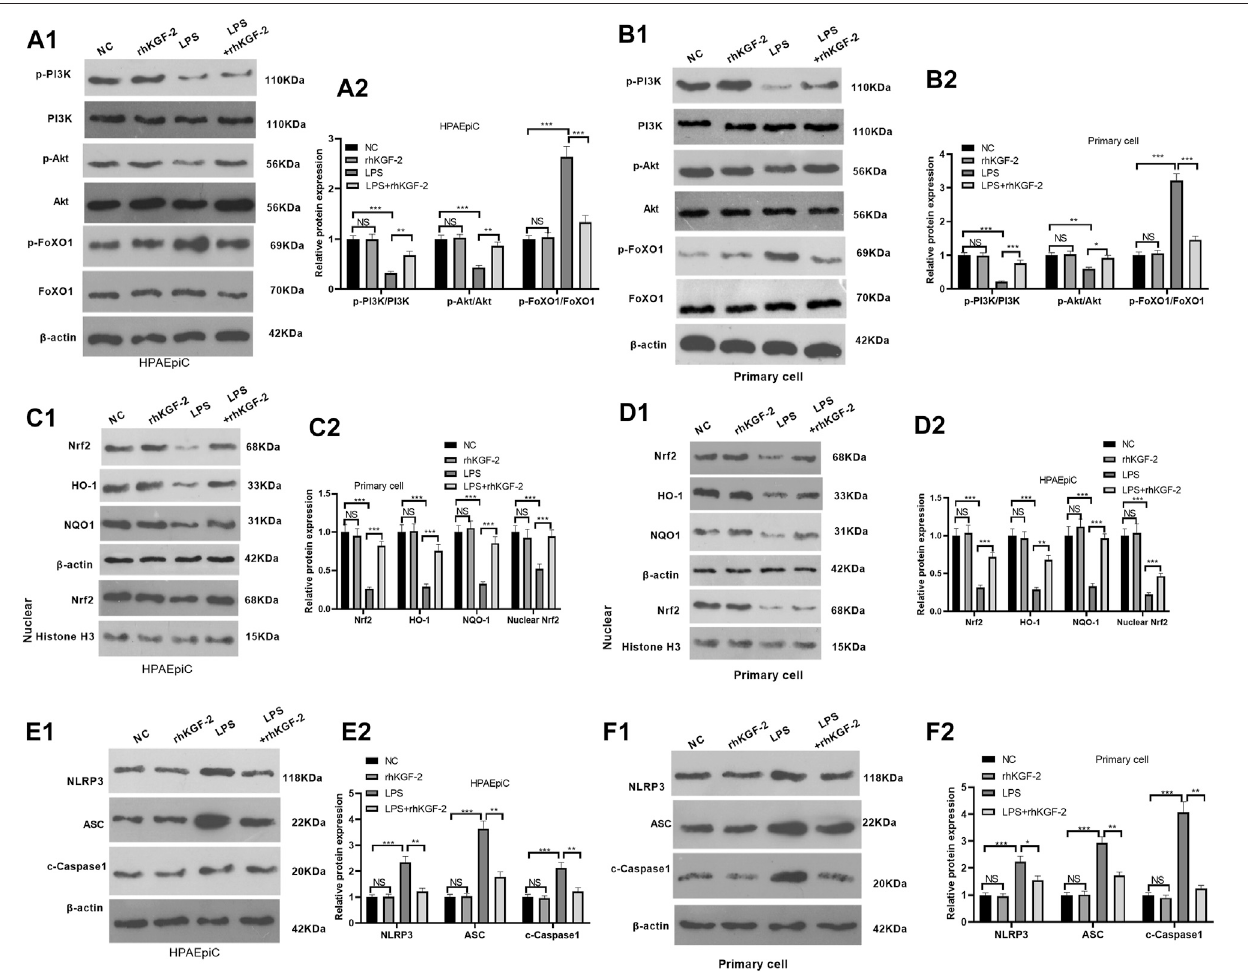
FIGURE 2 | The effect of rhKGF-2 on the expression of PI3K/Akt, Nrf2/HO-1/NQO1, and FoxO1-NLRP3-ASC-Caspase1 in fl ammasome. The HPAEpiC cells and primaryratalveolarepithelialcellsweretreatedwithLPS(10 μ g/ml)and/orrhKGF-2(10 ng/ml)for24 h. A1-A2 :WBwascarriedouttodeterminetheexpressionofPI3K/ Akt and FoxO1 in HPAEpiC cells. B1-B2 : WB was carried out to determine the expression of PI3K/Akt and FoxO1 in primary rat alveolar epithelial cells. C1-C2 . The protein levels of Nrf2, HO-1 and NQO1 in the HPAEpiC cells were detected by WB. D1-D2 . The protein levels of Nrf2, HO-1 and NQO1 in the primary rat alveolar epithelial cells were detected by WB. E1-E2 . WB was conducted to detect NLRP3-ASC-Caspase1 in HPAEpiC cells. F1-F2 . WB was conducted to detect NLRP3- ASC-Caspase1 in primary rat alveolar epithelial cells. The p-PI3K, p-AKT and p-FoxO1 were calculated using PI3K, AKT and FoxO1 as internal control, respectively. β -actin wasthe internal control of Nrf2, HO-1, NQO1 and NLRP3-ASC-Caspase1. Nuclear Nrf2 was calculated using HistoneH3 as internal control. The relative protein expression ( Y -axis) was calculated as fold change of NC group. The X -axis showed the grouping names. Data are expressed as mean ± SD. All experiments were repeated for three times. Data difference was analyzed via ANOVA, and Student ’ s t test. NS P > 0.05, ** p < 0.01, *** p < 0.001. N (cid:2) 3.